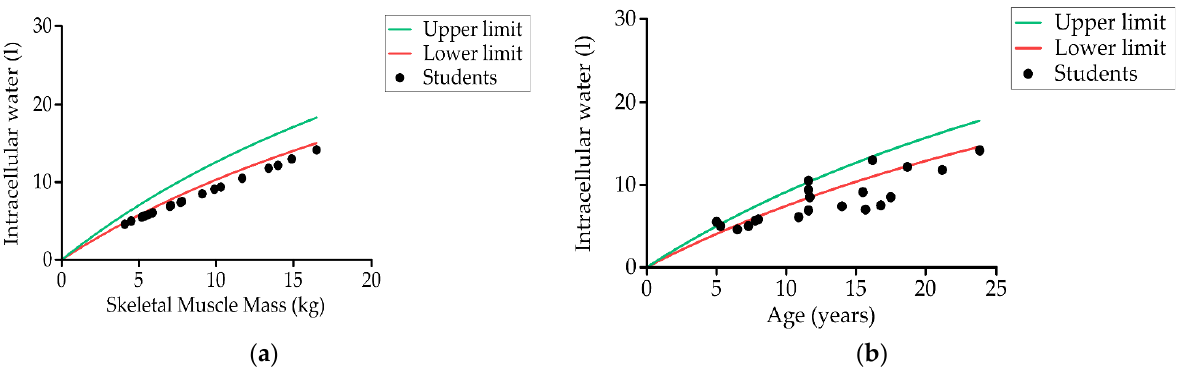
Figure 5. Relationship between students’ ( a ) intracellular water and skeletal muscle mass (kg), and ( b ) intracellular water and